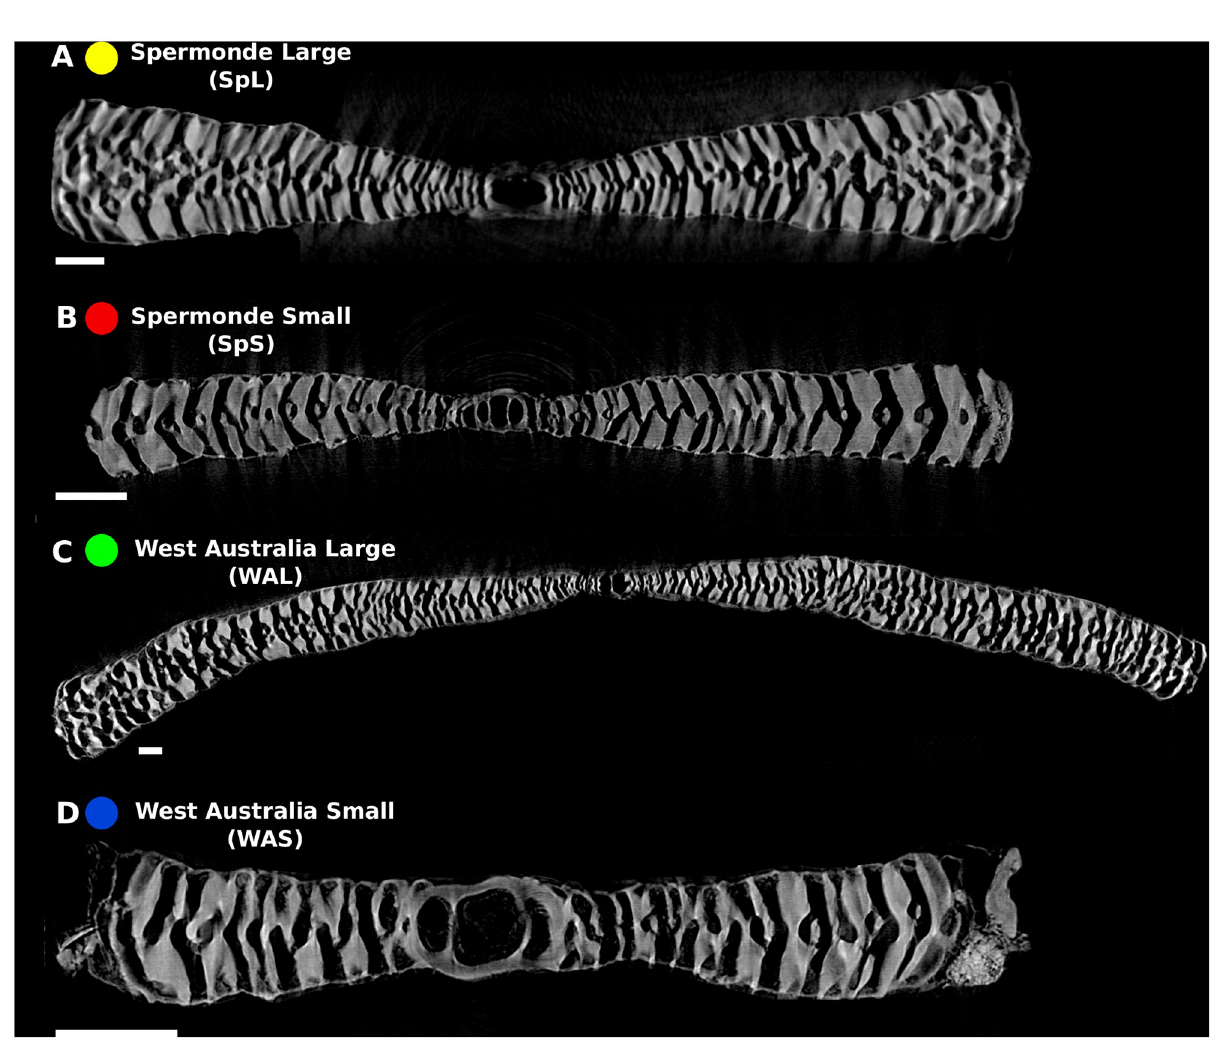
Fig 3. Virtual vertical cross sections through the A forms of the four morphotypes of Amphisorus recognised in this paper. A) Spermonde Large (SpL). Note the intermediate skeleton rapidly increasing in thickness towards the margin, while the marginal chamberlets are well developed and have a more or less constant thickness following the development of the intermediate skeleton. B) Spermonde Small (SpS). Note the absence of the intermediate skeleton. C) West Australia Large (WAL). Note the intermediate skeleton increasing in thickness towards the margin, while the marginal chamberlets are narroe and become thinner towards the margin. D) West Australia small (WAS). Note the absence of the intermediate skeleton. Scale bar = 200 μ